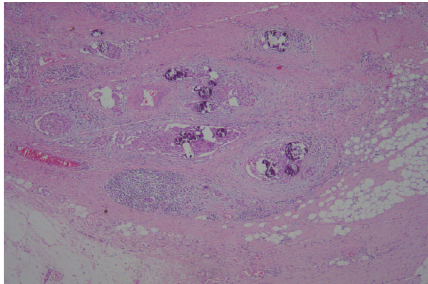
Figure 4: Extrathyroidal extension of papillary thyroid carcinoma was noted (H-E stain × 40).